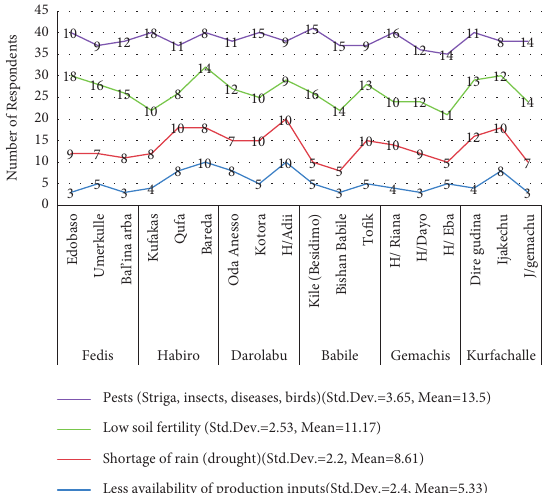
Pests (Striga, insects, diseases, birds)(Std.Dev.=3.65, Mean=13.5) Low soil fertility (Std.Dev.=2.53, Mean=11.17) Shortage of rain (drought)(Std.Dev.=2.2, Mean=8.61) Less availability of production inputs(Std.Dev.=2.4, Mean=5.33) Figure 4: Farmers’ responses on the sorghum production constraints in the surveyed sites.